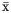
Overview of grouped scores on the three topics assessed in the survey: (A, top panel) infectious diseases, (B, middle panel) climate change and (C, lower panel) the effect of climate change on infectious diseases. Results are given for the total sample (n = 458), participants without (n = 255) and with (n = 203) background in natural sciences. Average scores are included in every plot (indicated by x¯ =). Scores are according to the percentage of the maximum score (85% and higher = A, 70 to 85% = B, 55 to 70% = C, 40 to 55% = D and scores 40% and lower = F). Box-scatter plot of individuals scores for the three subsets are visualized on the right hand side. Significance as *** at p-value < 0.001 and **** p-value < 0.0001.